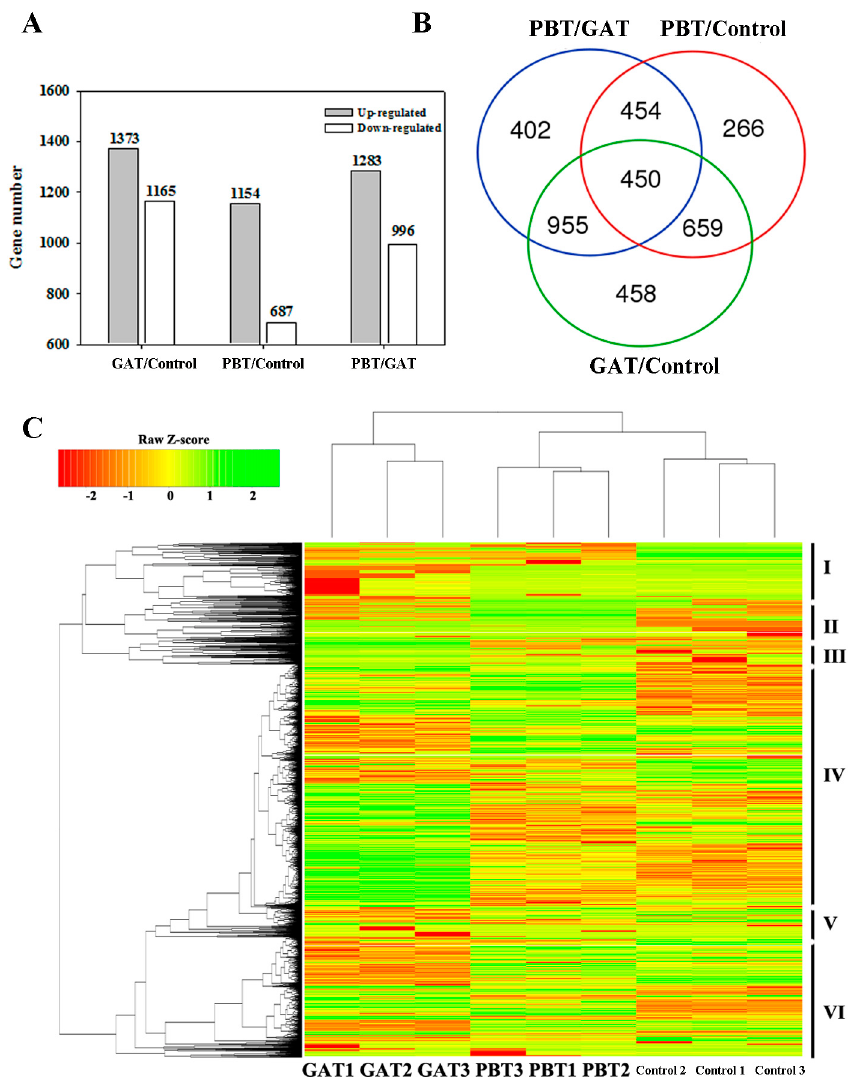
Figure 3. ( A ) Number of DEGs in different comparisons; ( B ) Venn diagram showing the commonly identified DEGs (differentially expressed genes) in different comparisons; ( C ) hierarchical clustering analysis of the DEGs (differentially expressed genes) among control, GAT, and PBT. The color bar on the left represents the log2 FPKM values. Red, yellow, and green indicate low, medium, and high FPKM (Fragments Per Kilobase of exon model per Million mapped reads) values, respectively.